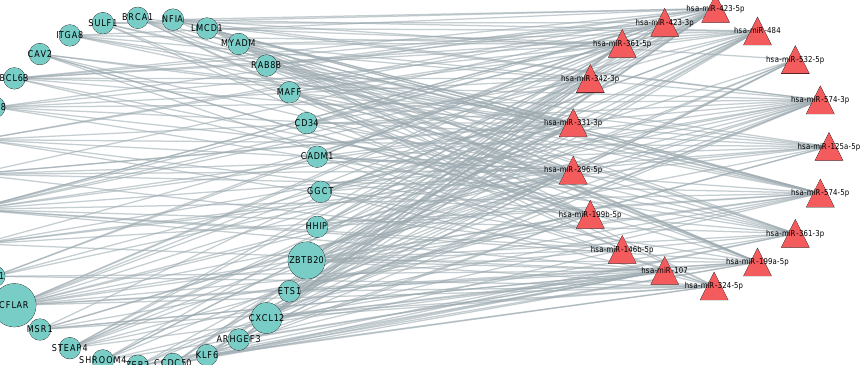
Figure 5. Network analysis of the interaction network between DEGs and DEMs. This figure only shows the interaction network of some important nodes. The red triangle represents miRNA; the green circle represents genes; the gray line represents the interaction. The size of circle (gene) reflects the degree centrality of the gene, i.e., a larger circle reflects more connections in this gene.